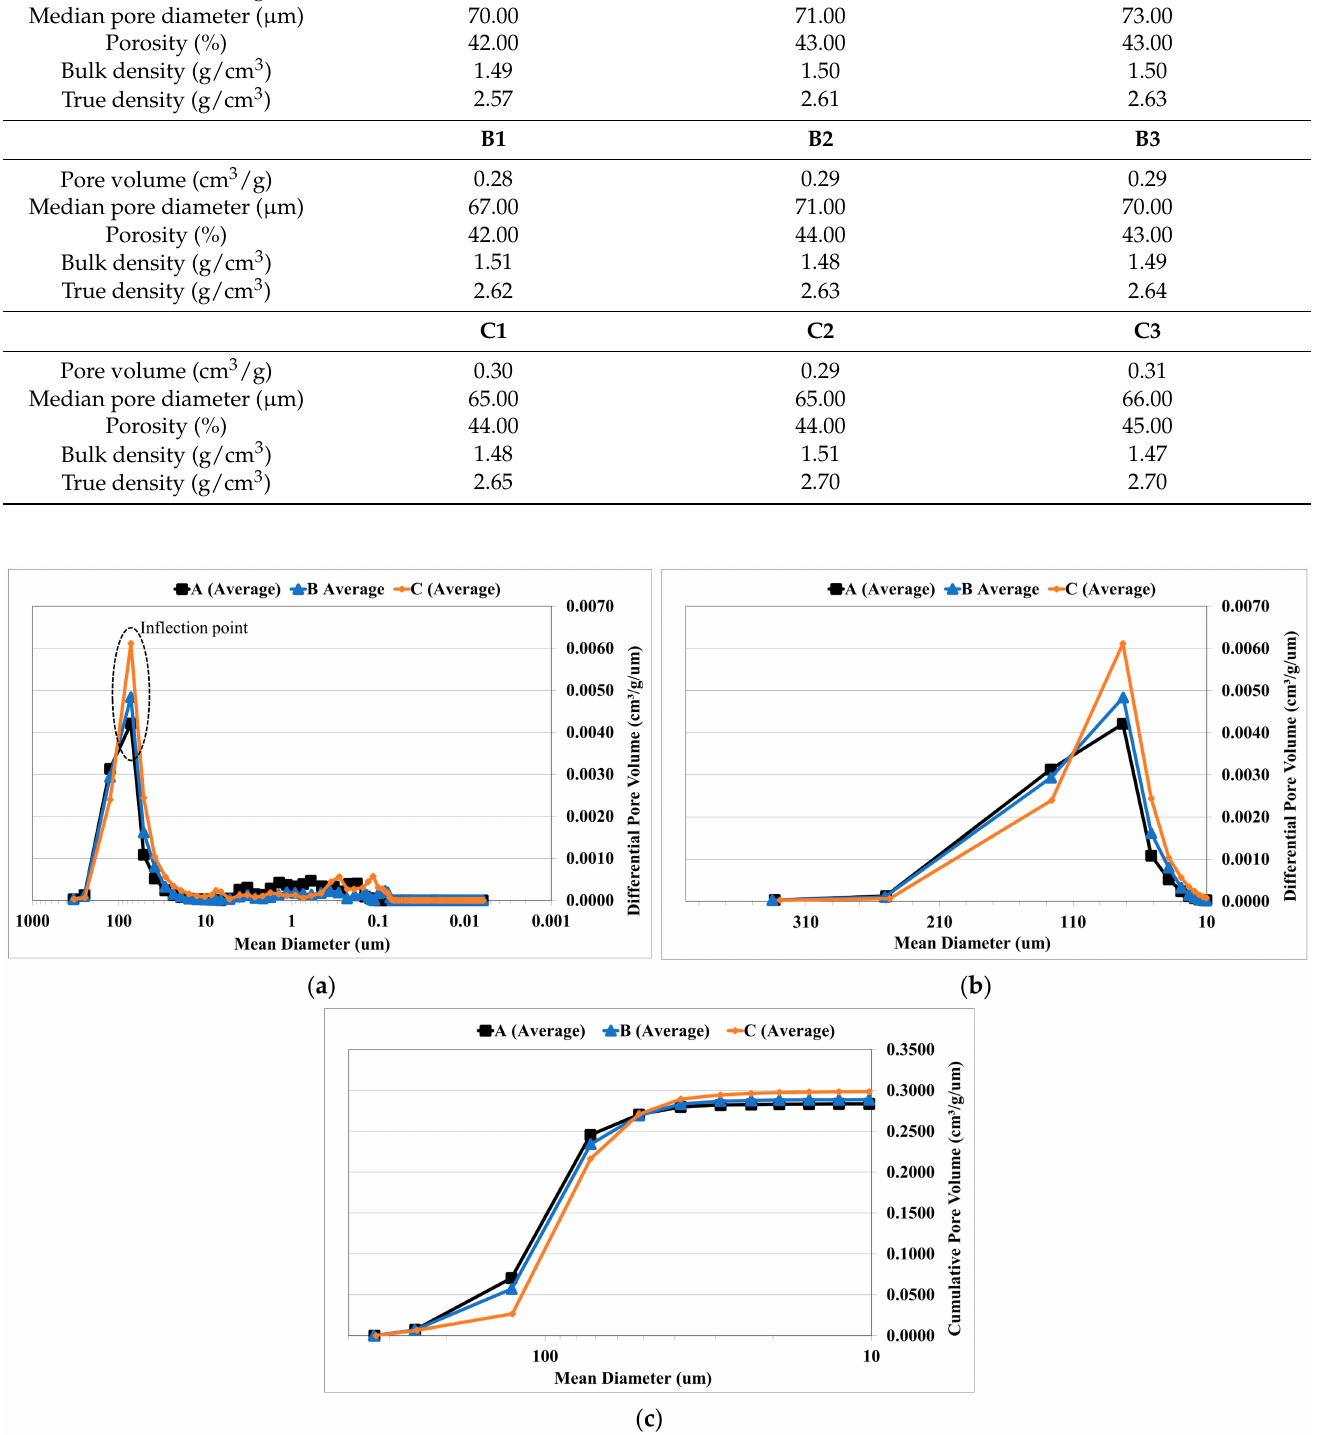
Figure 8. ( a ) Differential volume intrusion curves for three samples A, B and C. ( b ) Differential intrusion curves for the three samples with a linear x -axis. ( c ) Cumulative intrusion curves for the three samples A, B and